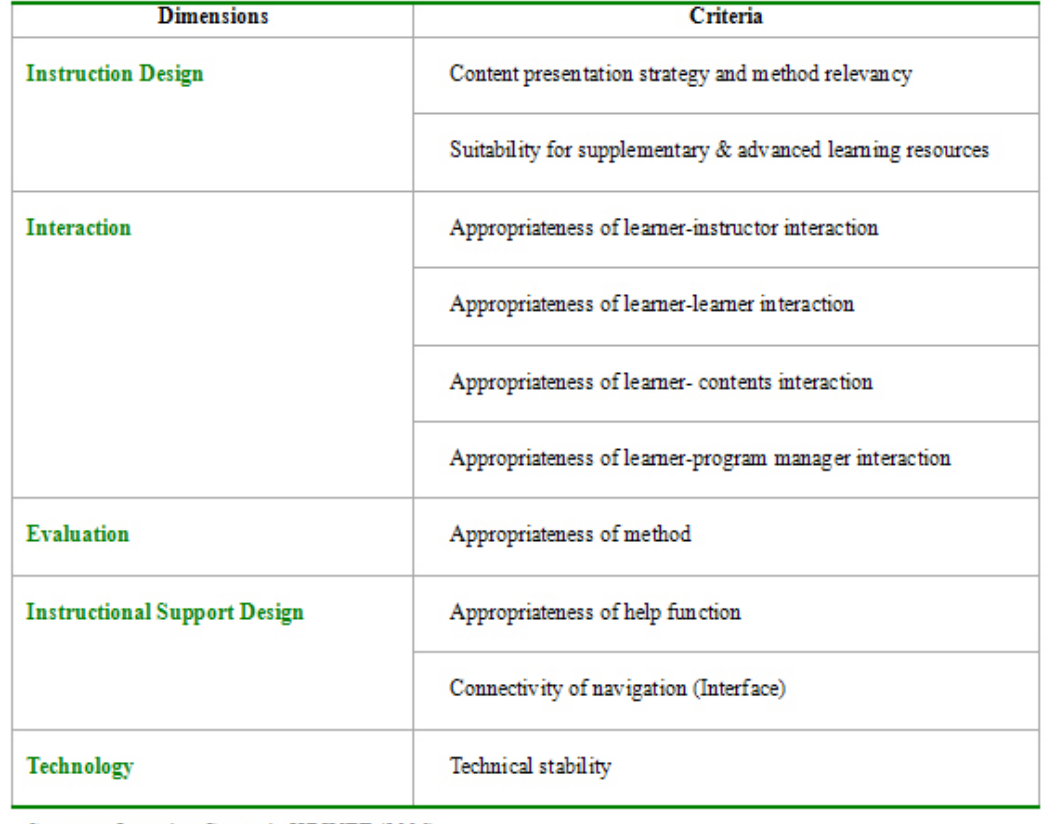
Table 7. The Evaluation Criteria for e-Learning